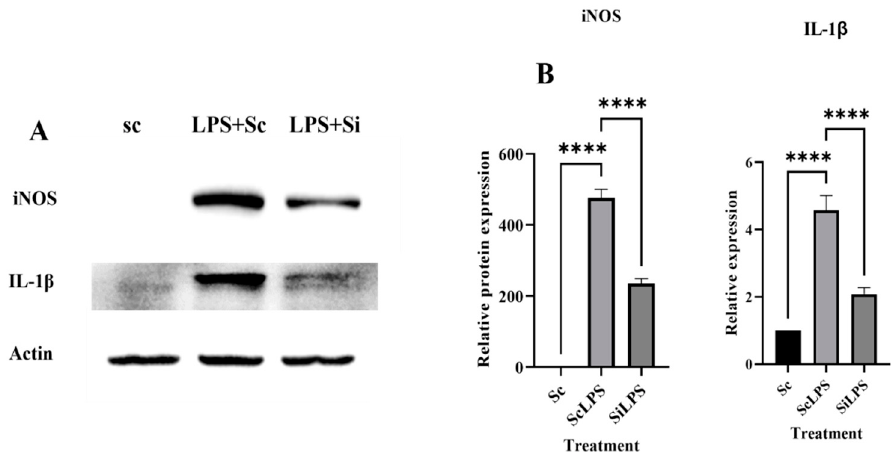
Figure 5. ( A ) iNOS and IL-1 β expression determined by western blot analysis ( B ) Represent densitometric analysis done by ImageJ software (1.53r). Here **** indicates the level of significance between Sc, ScLPS and SiLPS,